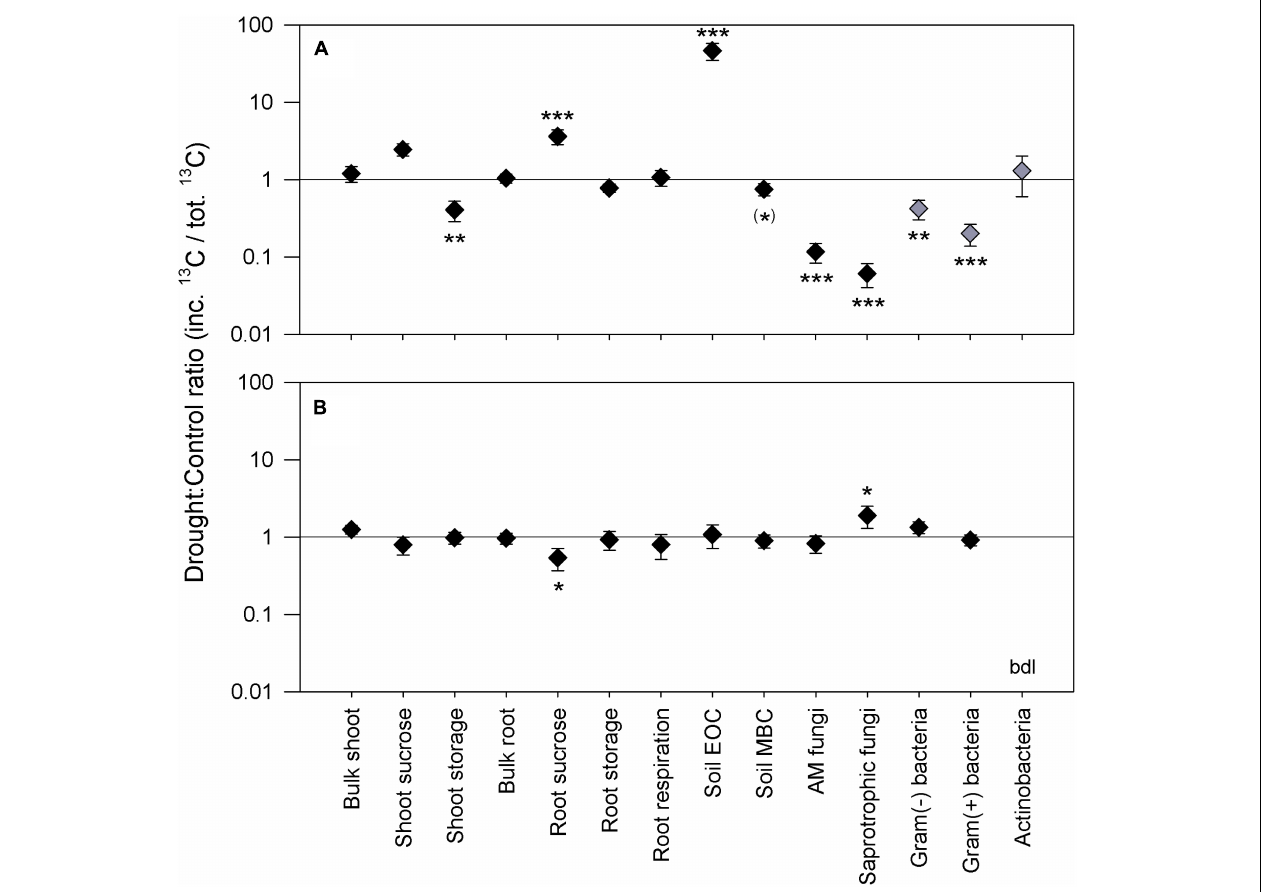
FIGURE 1 | Effects of drought on C allocation patterns at the peak drought (A) and recovery (B) labeling campaigns. The drought to control ratio of the relative 13 C allocation is shown, i.e., the amount of incorporated 13 C (inc. 13 C) in each pool that was recovered from the total 13 C uptake (tot. 13 C), averaged for the samplings at 24 and 72 h after pulse labeling. The graph only highlights the strongest effects, and additional data for individual sampling points, including 15 min and 120 h, can be found in Supplementary Figure S4 . Black symbols represent the mean of n = 6 control/drought pairs, and gray symbols the mean of n = 3 control/drought pairs. Error bars were obtained by propagating the SE from the replicates of each treatment, control and drought, respectively. Asterisks indicate levels of significance for drought effects (df = 1) from the linear mixed-effects models: ∗∗∗ P χ 2 < 0.001, ∗∗ P χ 2 < 0.01, ∗ P χ 2 < 0.05, and ( ∗ ) P χ 2 < 0.1. The “bdl” notation stands for below detection